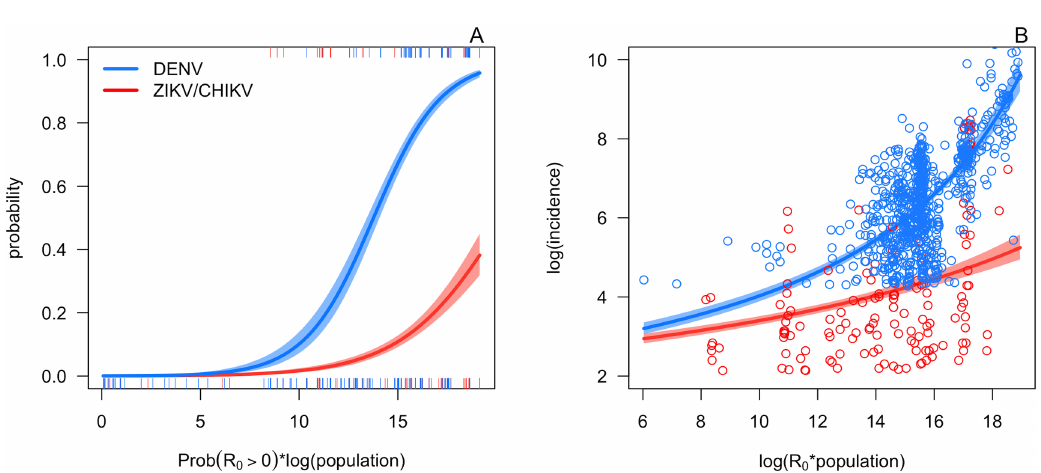
Fig 3. Ae . aegypti R 0 ( T ) and population size predict the probability and magnitude of transmission of DENV, CHIKV, and ZIKV across the Americas. A, log ( p ) * GR 0 (the posterior probabilitythat R 0 ( T ) > 0 times the log of population size) versus the probabilityof local transmission in the data. B, log ( p * R 0 ( T )) (log of R 0 ( T ) times the population size) versus the log of incidence, given that it exceeds the threshold for local transmission. Tick-marks and points: humantransmissionoccurrence and incidencedata, respectively,by country-week in the Americas and Caribbean. Lines and shaded areas: mean and 95% CI from GLM fits for DENV (blue) and CHIKV and ZIKV (red). For simplicity, we show the models that only includethe covariates log ( p ) * GR 0 or log ( p * R 0 ( T )), respectively,and do not includethe socioeconomic covariates(modelsPA6 and IM4 in Table D in S2 Text). For each case report data point, log ( p ) * GR 0 and log ( p * R 0 ( T )) were calculatedat the mean temperature 10 weeks prior to the reportingweek [40].